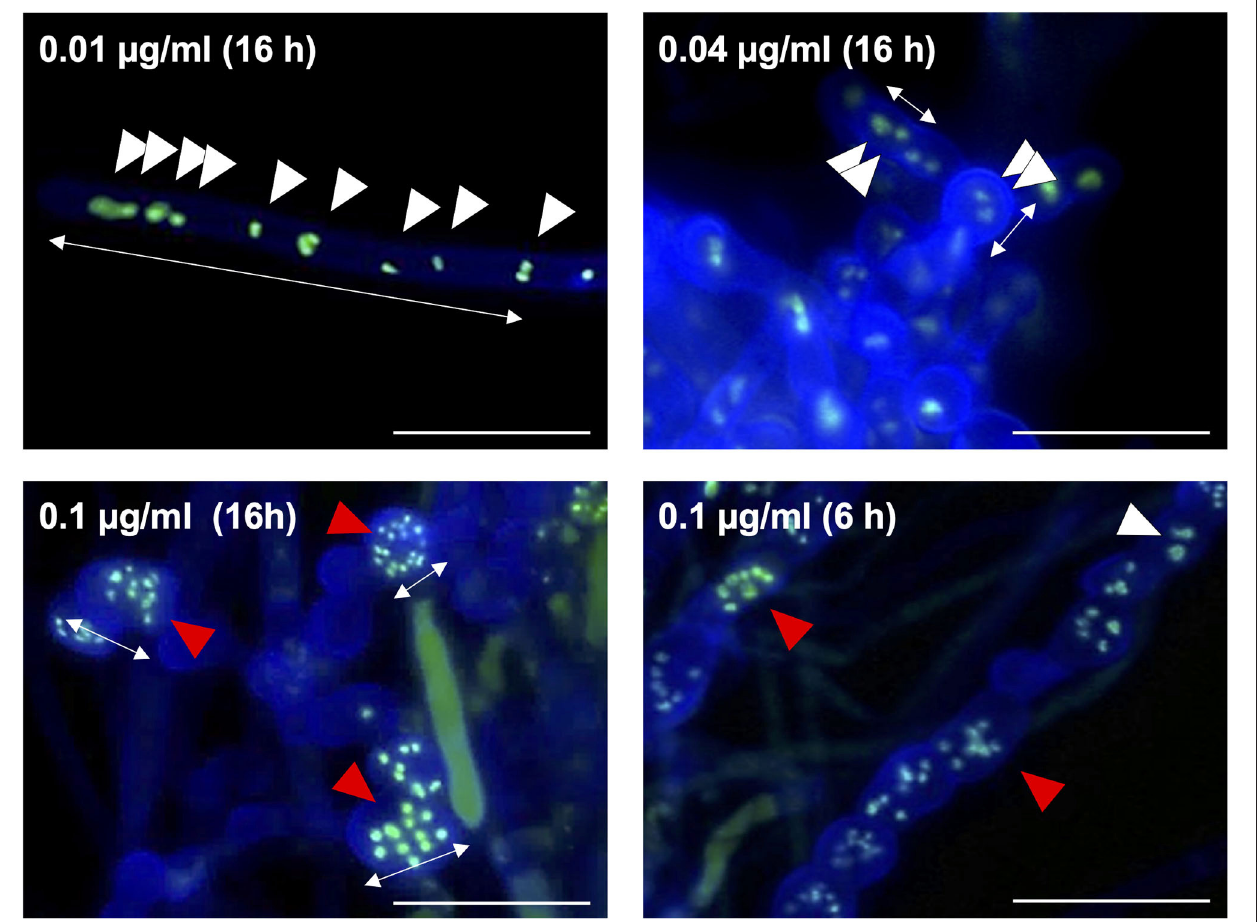
FIGURE 8 | Morphology of hyphae and nuclei after treatment with fludioxonil in the wild-type strain. Conidia (1 × 10 7 cells) were incubated in liquid CDTFY medium (67ml) for 20h at 37 ◦ C. Mycelia were transferred to CDTFY medium with the indicated concentrations of fludioxonil and incubated for 6 or 16h at 37 ◦ C. Lines with arrows indicate distance between septa. White arrowheads indicate nuclei. Red arrowheads indicate fragmented nuclei. Scale bars, 35 µ